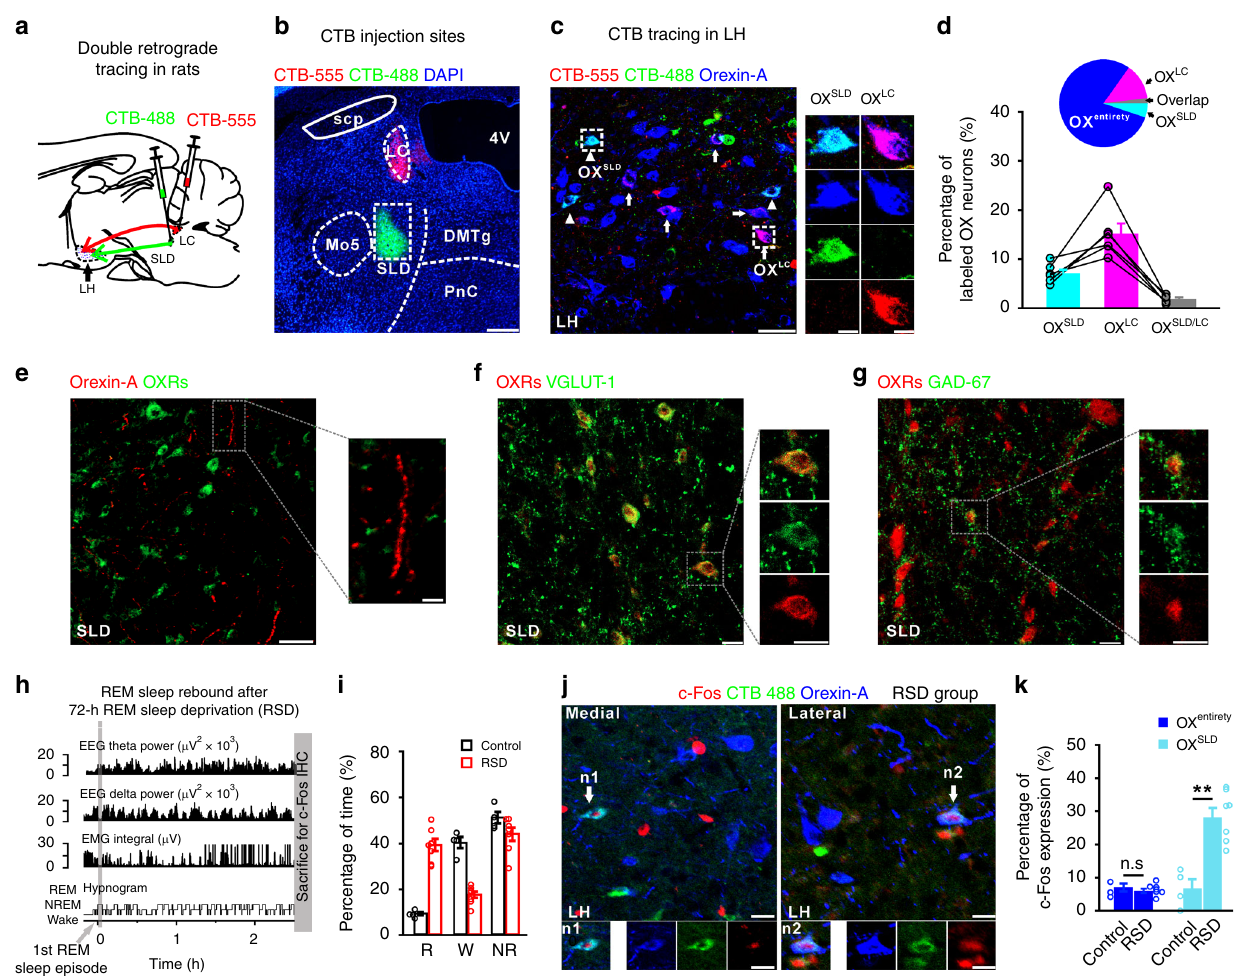
Fig. 1 LH OX SLD neurons show REM sleep-related activation. a , b Schematic drawing ( a ) and representative CTB-555 (red)/CTB-488 (green) injections ( b ) for retrograde tracing. LH lateral hypothalamus, scp superior cerebellar peduncle. Mo5 trigeminal motor nucleus, 4V 4th ventricle, DMTg dorsomedial tegmental area, PnC caudal pontine reticular nucleus. Scale bar: 500 μ m. c Representative SLD-projecting (OX SLD , arrow heads, CTB-488 + /orexin-A + , cyan) and LC-projecting (OX LC , arrows, CTB-555 + /orexin-A + , purple) orexin-A + (blue) neurons in the rat LH. Scale bar: 50 μ m. Examples (square boxes) were magni fi ed on the right. Scale bars: 10 μ m. d Percentage of orexin (OX) neurons projecting to the SLD, LC, and both (OX SLD/LC ), respectively ( n = 6 rats; analysis of 3902 orexin neurons). e Expression of OXRs (green) and orexin-A + varicosities (red) in the rat SLD. Scale bars: left, 50 μ m; right, 10 μ m. f , g Expression of OXRs (red) with VGLUT1 (green, f ) and GAD 67 (green, g ) in the rat SLD. All scale bars: 20 μ m. h Representative sleep/wakefulness architecture following the 72-h RSD. The rat was sacri fi ced for c-Fos immunostaining (IHC) after 2.5 h from the fi rst REM sleep episode (gray arrow). Control rats were set with normal sleep/wakefulness cycle and underwent same processes. i Percentage of time spent in REM sleep (R), wakefulness (W), and NREM sleep (NR) during the 2.5 h preceding sacri fi ce in the control (black, n = 4) and RSD (red, n = 7) rats. j Representative c-Fos (red) expression in orexin-A + (blue) and OX SLD (cyan) neurons (RSD group). C-Fos-positive OX SLD neurons (arrows) from the medial (n1) and lateral (n2) part of the LH were presented below. All scale bars, 20 μ m. k Percentage of c-Fos expression in the OX entirety (blue, two-sided unpaired t -test; t 9 = 0.817, P = 0.435) and OX SLD neurons (cyan, two-sided unpaired t -test; t 9 = 4.839, P = 9.221× 10 − 4 ) in the control ( n = 4, analysis of 2767 OX entirety and 178 OX SLD neurons) and RSD ( n = 7, analysis of 6012 OX entirety and 370 OX SLD neurons) rats, respectively. Data represent mean ± SEM. ** P < 0.01. Source data are provided as a Source Data fi